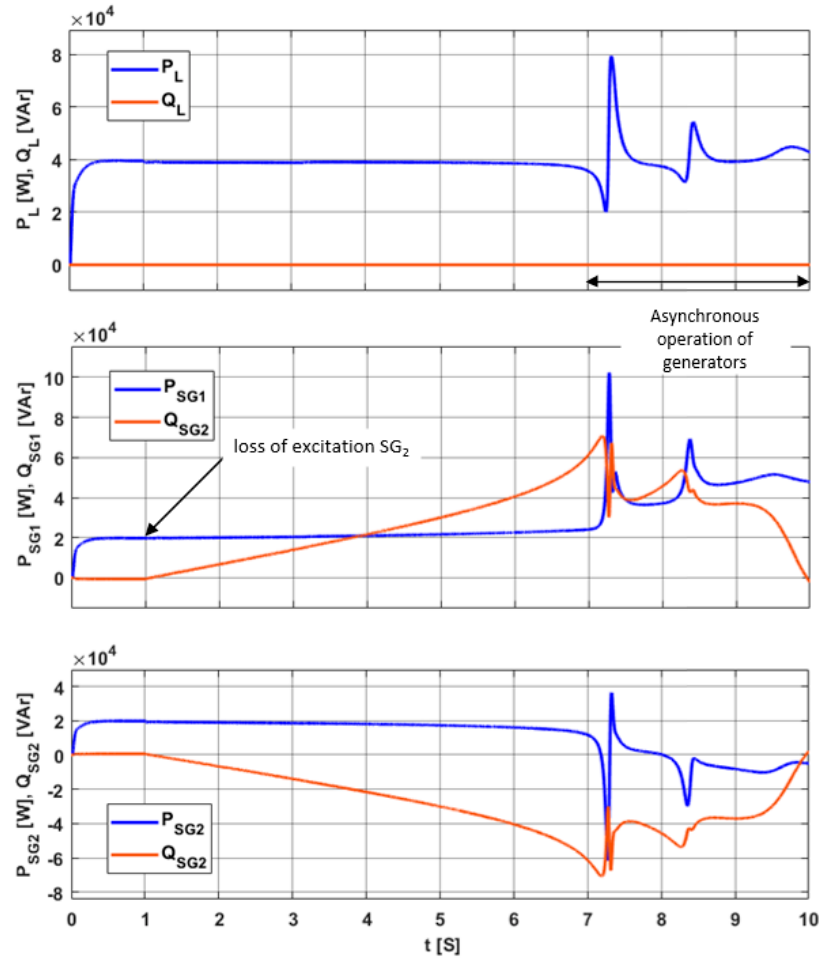
Figure 13. Energy characteristics of the active and reactive power of the load ( P L , Q L ), as well as the active and reactive power for SG 1 ( P SG1 , Q SG1 ) and SG 2 ( P SG2 , Q SG2 ) with an active load.